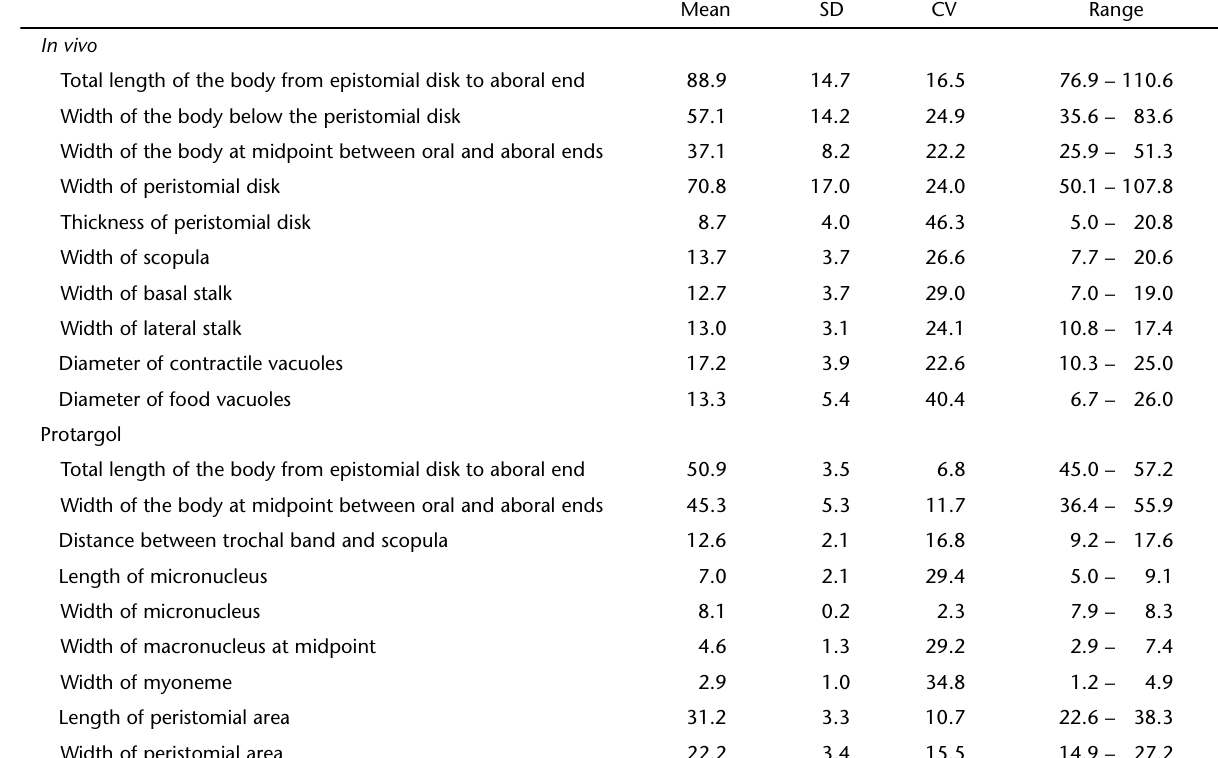
Table I. Measurements (µm) of C. polypinum attached to P. figulina from São Pedro stream, southeast Brazil. A total number of 15 zooids were measured in vivo and 15 zooids after protargol staining. (Mean) Arithmetic mean, (SD) standard deviation, (CV) coefficient of variation